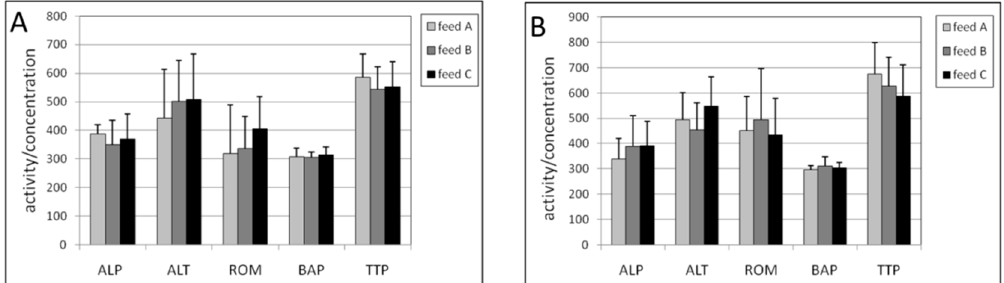
Figure 1. ( A ) Plasma activities in male; and ( B ) female mice of alkaline phosphatase (ALP), alanine aminotransferase (ALT) and plasma concentrations of reactive oxygen metabolites (ROM), biological antioxidant potential (BAP) and total thiol levels in proteins (TTP) after exposure to the three different diets. The levels of ALP, ALT and BAP were multiplied by a factor of 3, 10 and 0.1, respectively to fit in the figure. The levels of feed B were tested statistically relative to those of feed A, and the levels of feed C relative to those of feed B. No statistical differences were found.